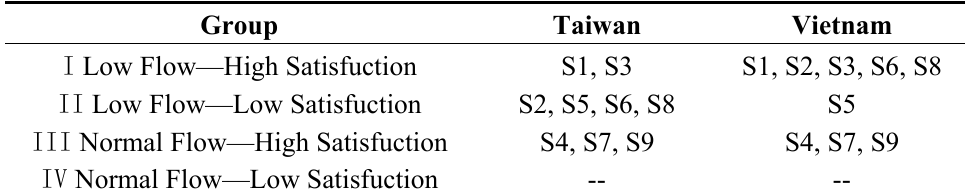
Table 2. Groups of